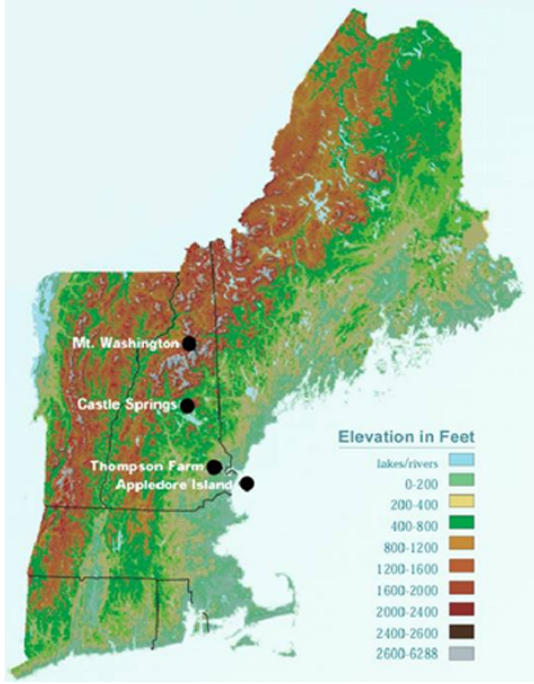
Fig. 1. Locations for the campaign: coastal site located at Thompson Farm in New Hampshire (43.11 ◦ N, 70.95 ◦ W); marine site located in the Gulf of Maine on Appledore Island (42.97 ◦ N, 70.62 ◦